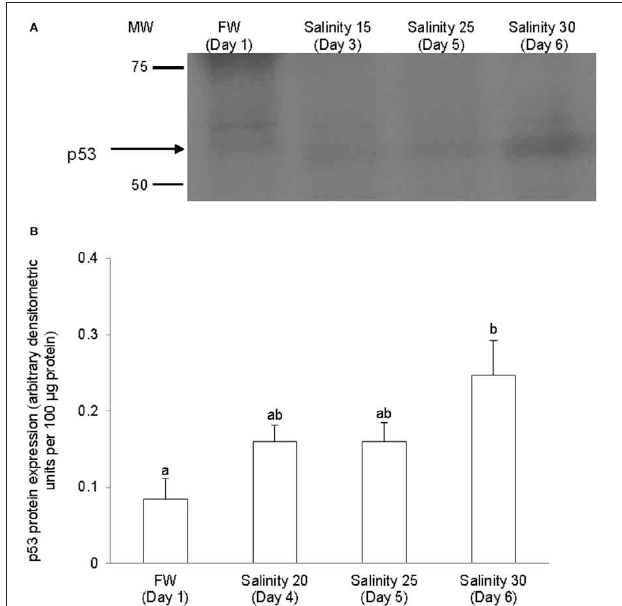
FIGURE 5 | Protein abundance of p53 in the gills of Anabas testudineus kept in freshwater (FW, control) or exposed to a 5-day progressive increase in salinity (S) from FW (day 1) to S 15 on day 3, S 25 on day 5 or S 30 (seawater) on day 6. (A) Immunoblots of p53. (B) The protein abundance of p53 expressed as arbitrary densitometric units per 100 μ g protein. Results represent mean + S.E.M. ( N = 4). Means not sharing the same letter are significantly different ( P < 0 .